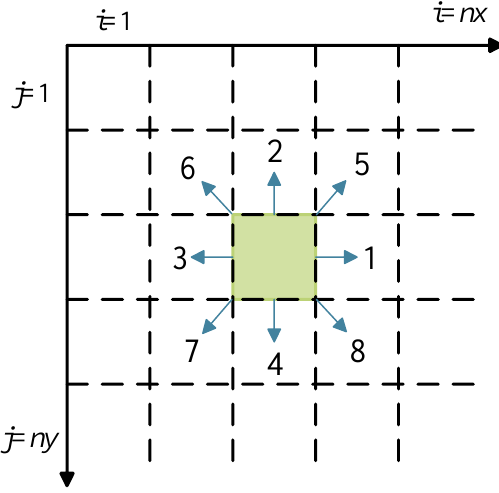
Figure 3. Schematic diagram of C-S-H nucleation growth direction.